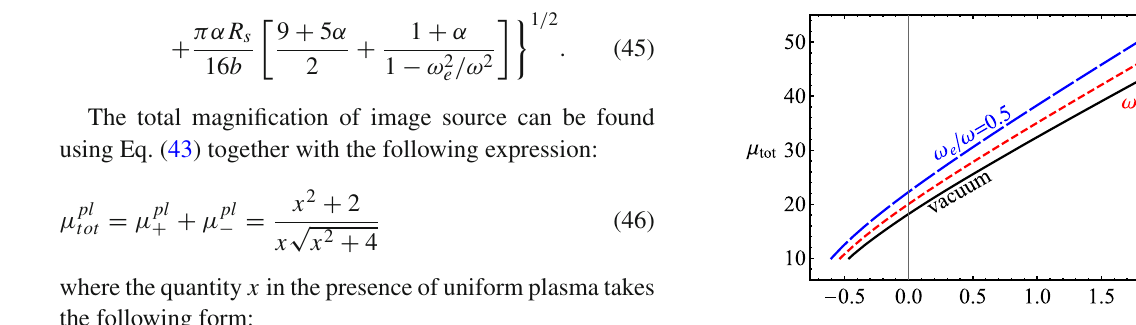
Fig. 4 Deflection angle ˆ α b as a function of the a impact parameter b , b MOG parameter and c plasma frequency for different type of plasma distributions. In the left panel we have used α = 0 . 2, in the middle one